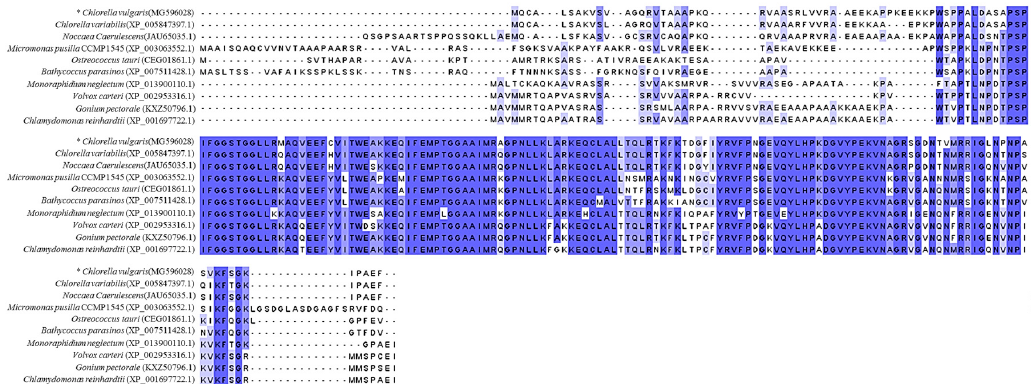
Figure 1. Alignment of amino acid sequence of photosystem I protein D ( psaD ) using the protein basic local alignment search tool (BLASTP) program against the National Center for Biotechnology Information (NCBI) database (https://blast.ncbi.nlm.nih.gov/Blast.cgi). The asterisk indicates the psaD sequence of C. vulgaris UTEX395 used for this study.